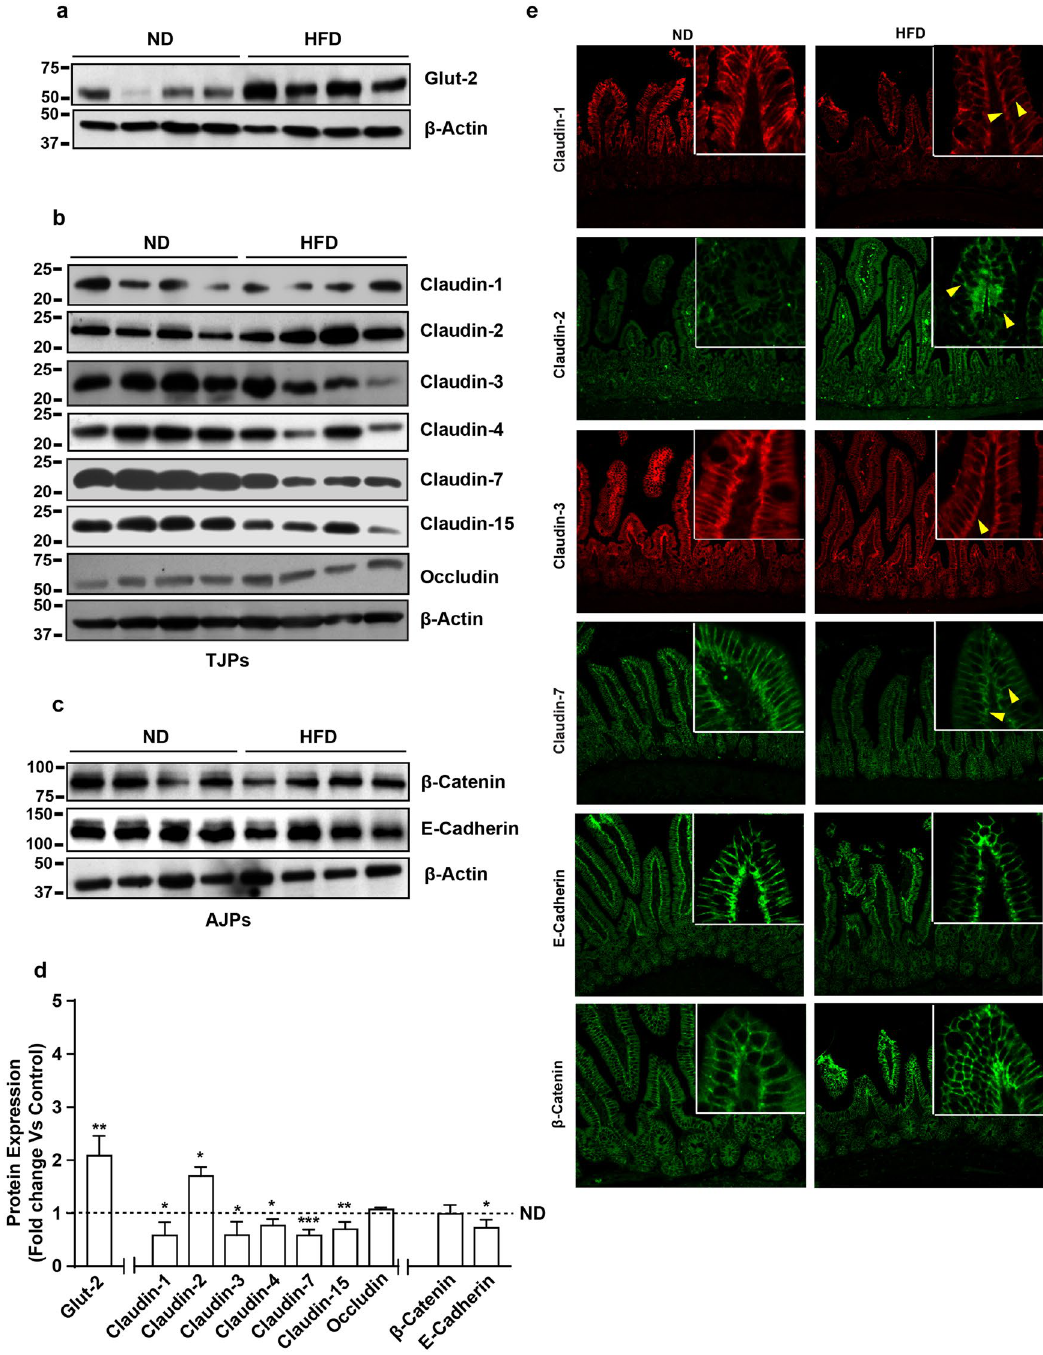
Figure 2. High fat diet induces restructuring of tight junction (but not adherent junction) to modulate mucosal barrier function in small intestine: Immunoblot analysis of total tissue lysate prepared using small intestine from mice fed on normal chow or high fat diet for 20 weeks (N = 4). ( a ) Glut-2 expression in HFD and ND-fed mice, as positive control; ( b ) Immunoblot analysis to determine changes in TJPs antigen-specific antibodies; ( c ) Immunoblot analysis to determine potential changes in AJPs (E-Cadherin and β -Catenin) in obese versus lean mice; ( d ) Quantitative analysis of immunoblot band intensity for respective protein; ( e ) Representative confocal immunofluorescent images of TJ and AJPs of small intestine from HFD- and ND-fed mice. Values are presented as mean ± SEM * P ≤ 0.05 compared to control (normal chow fed mice; ND)